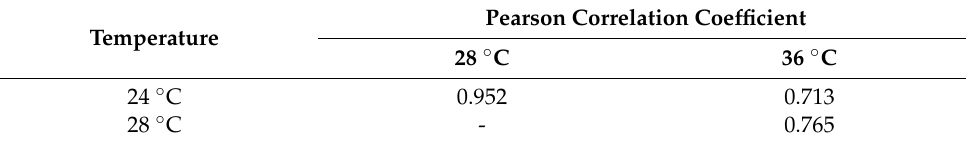
Table 2. Correlation of bacterial wilt severity between temperatures in 50 tomato